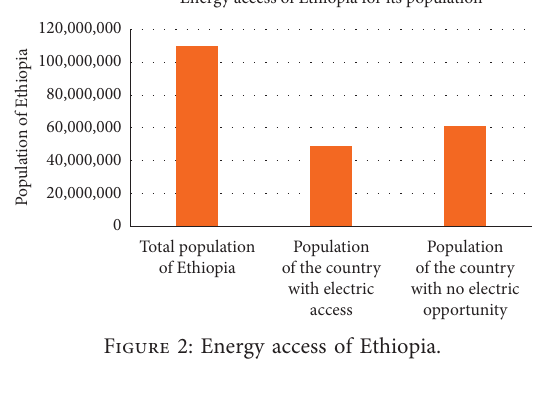
Figure 2: Energy access of